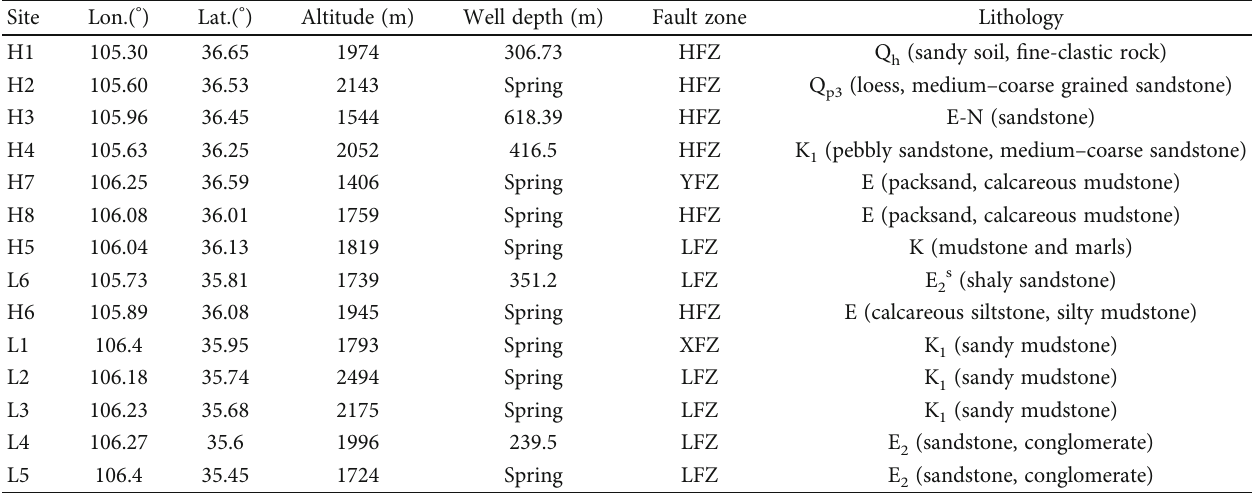
Table 1: The sampling location and lithology of each site.